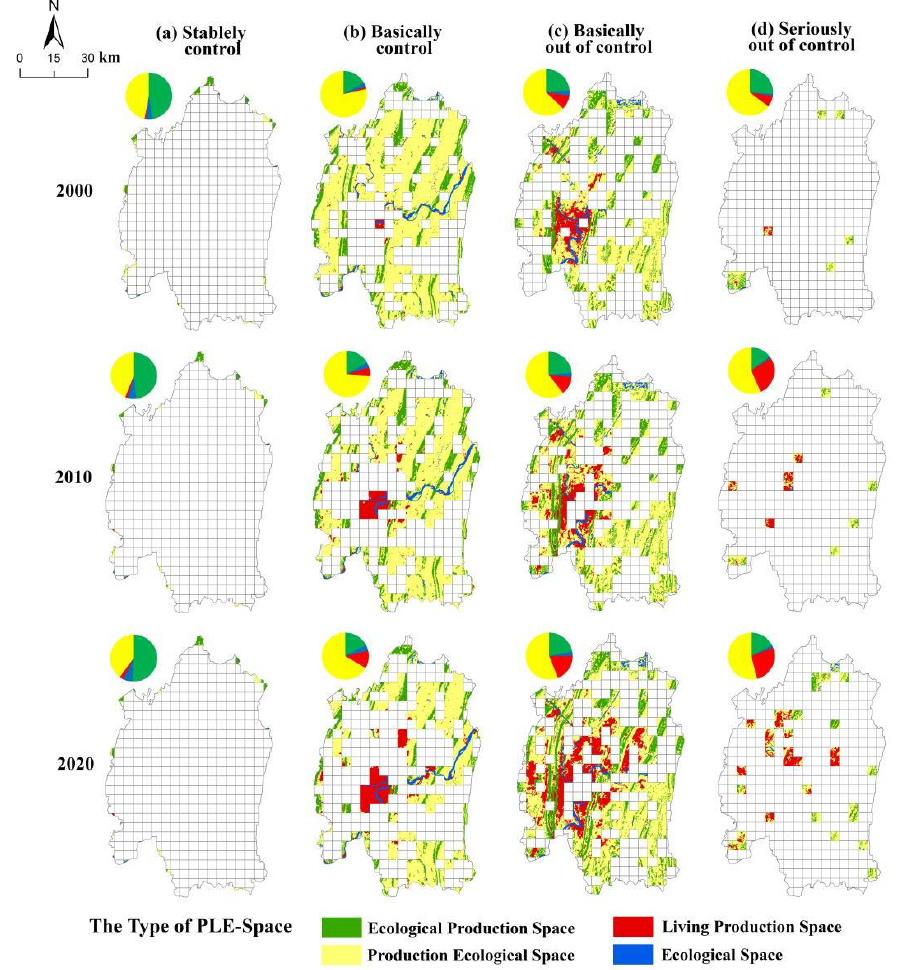
Figure 6. The evolution characteristics of the PLES in the LUCs zone from 2000 to 2020. Table 6. The area ratio statistics of LUCs zones from 2000 to 2020. Area Ratio (%) Conflict Zone